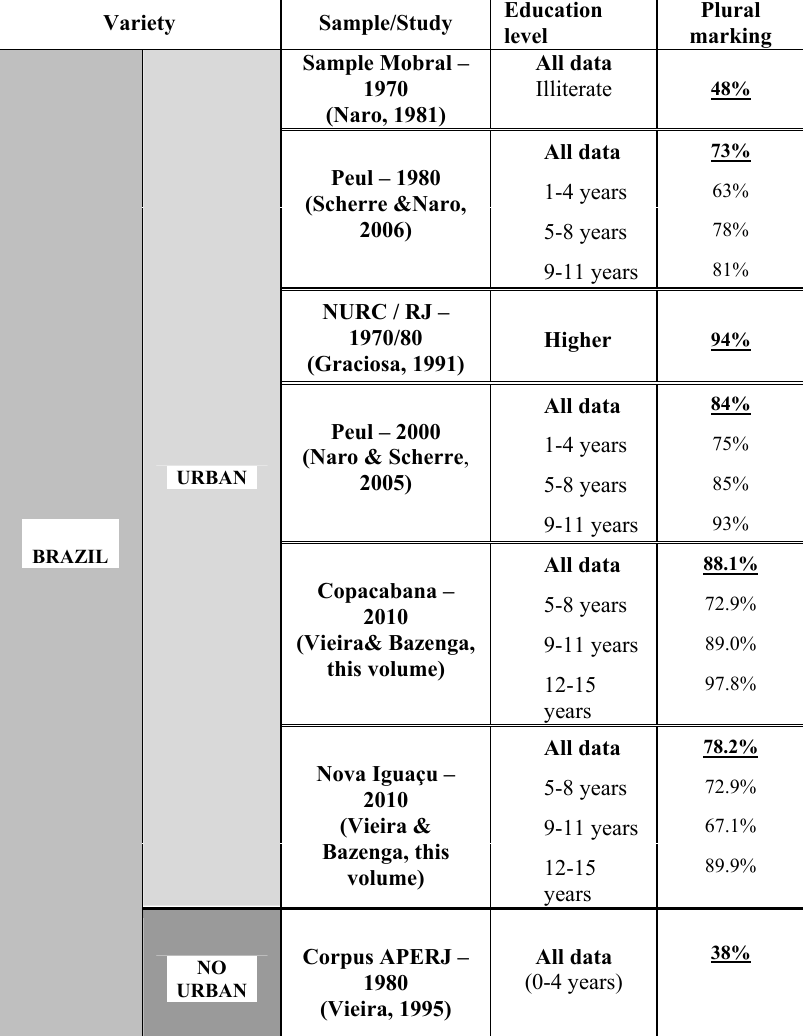
Table XXII: Frequency of plural marks in different studies on third plural verbal agreement in BP Variety